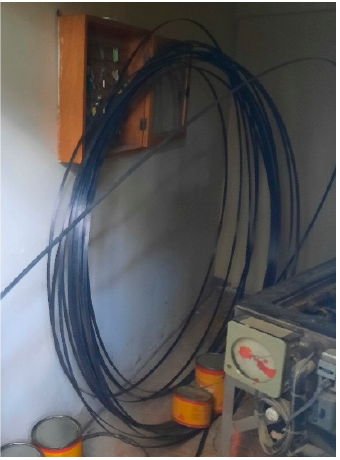
Figure 1. Original carbon fiber roll. Table 1. Technical data of CFRP.